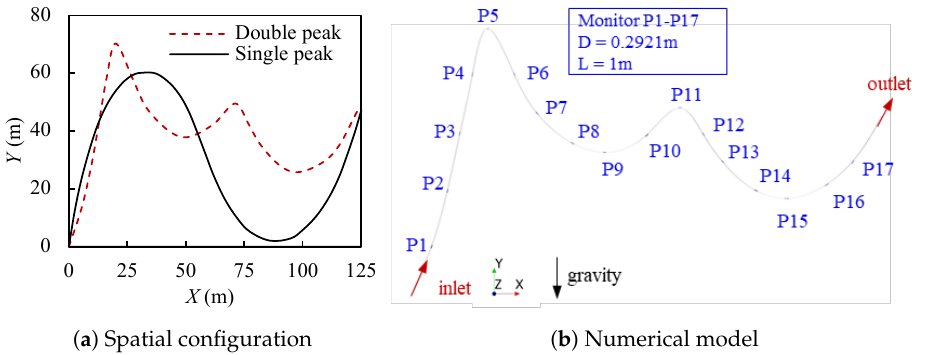
Figure 14. Spatial configuration and numerical model of the double-peak riser. Table 4. Positions and inclined angles of the monitors in the double-peak